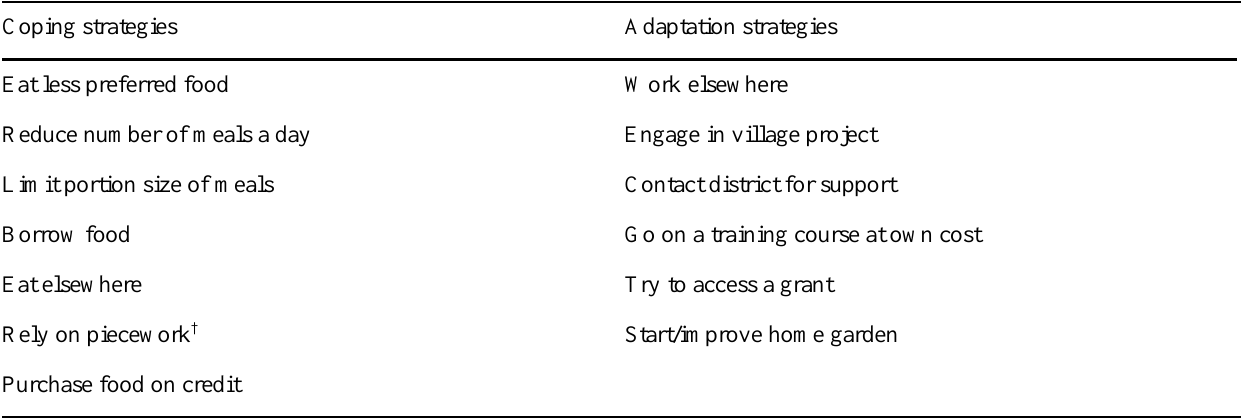
Table 2. Choice set of coping/adaptation strategies used in stated preference